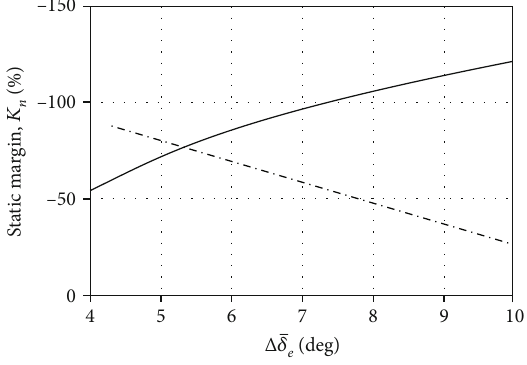
Figure 8: Determination of K min saturation. Dashed line: trimmed